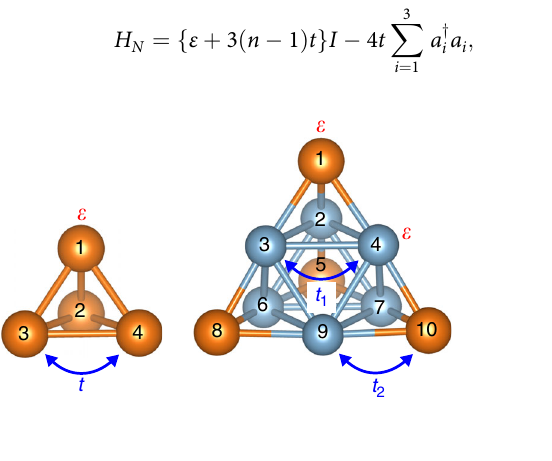
Fig. 2 Model parameters for four-atom and ten-atom systems